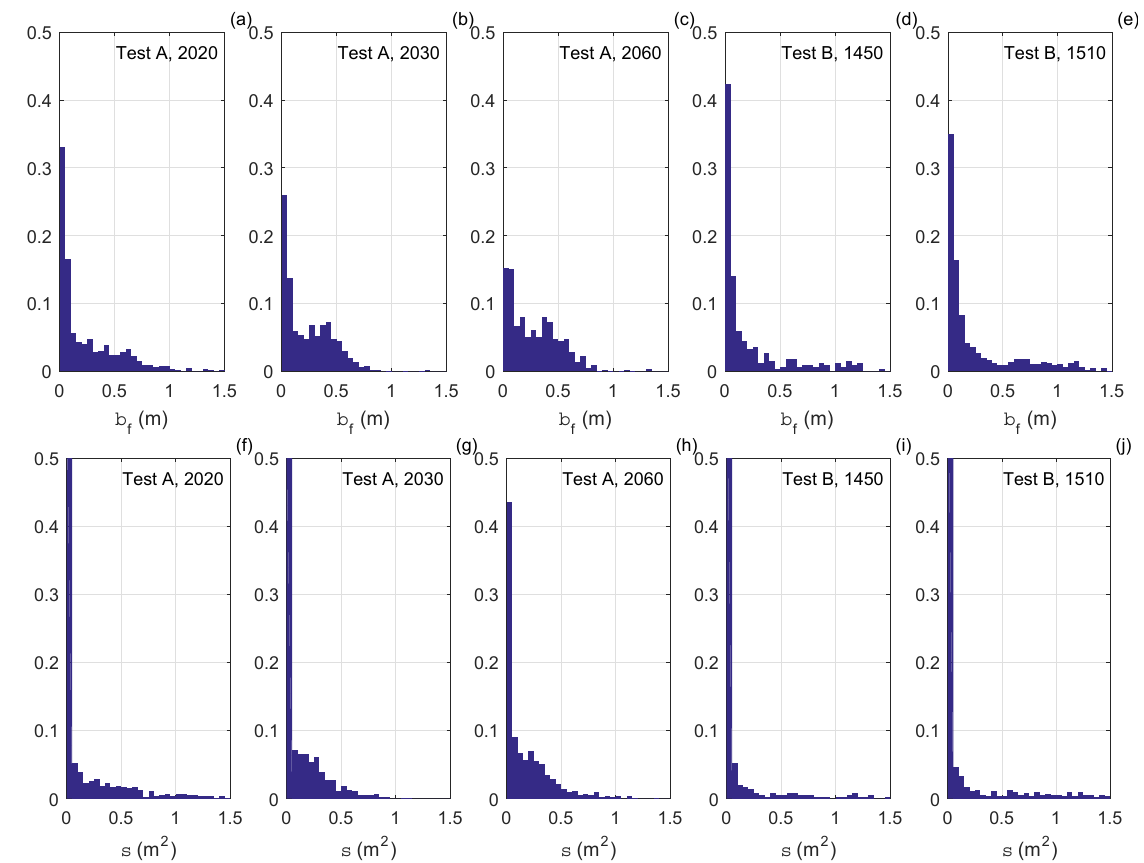
Figure 5. Histograms of b f (a–e) and s (f–j) from all five tests analyzed. Bin width equals 0.05m and 0.05m 2 ,